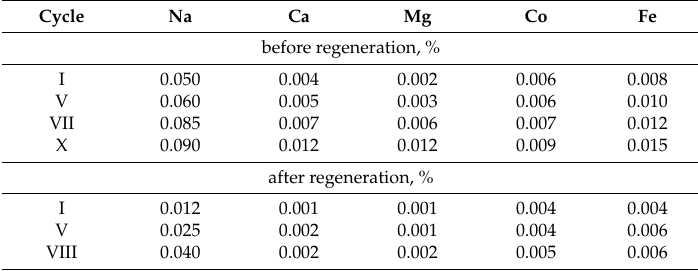
Table 5. Concentration of the selected impurities in the produced hydrated nickel(II) perrhenate. Cycle Na Ca Mg Co